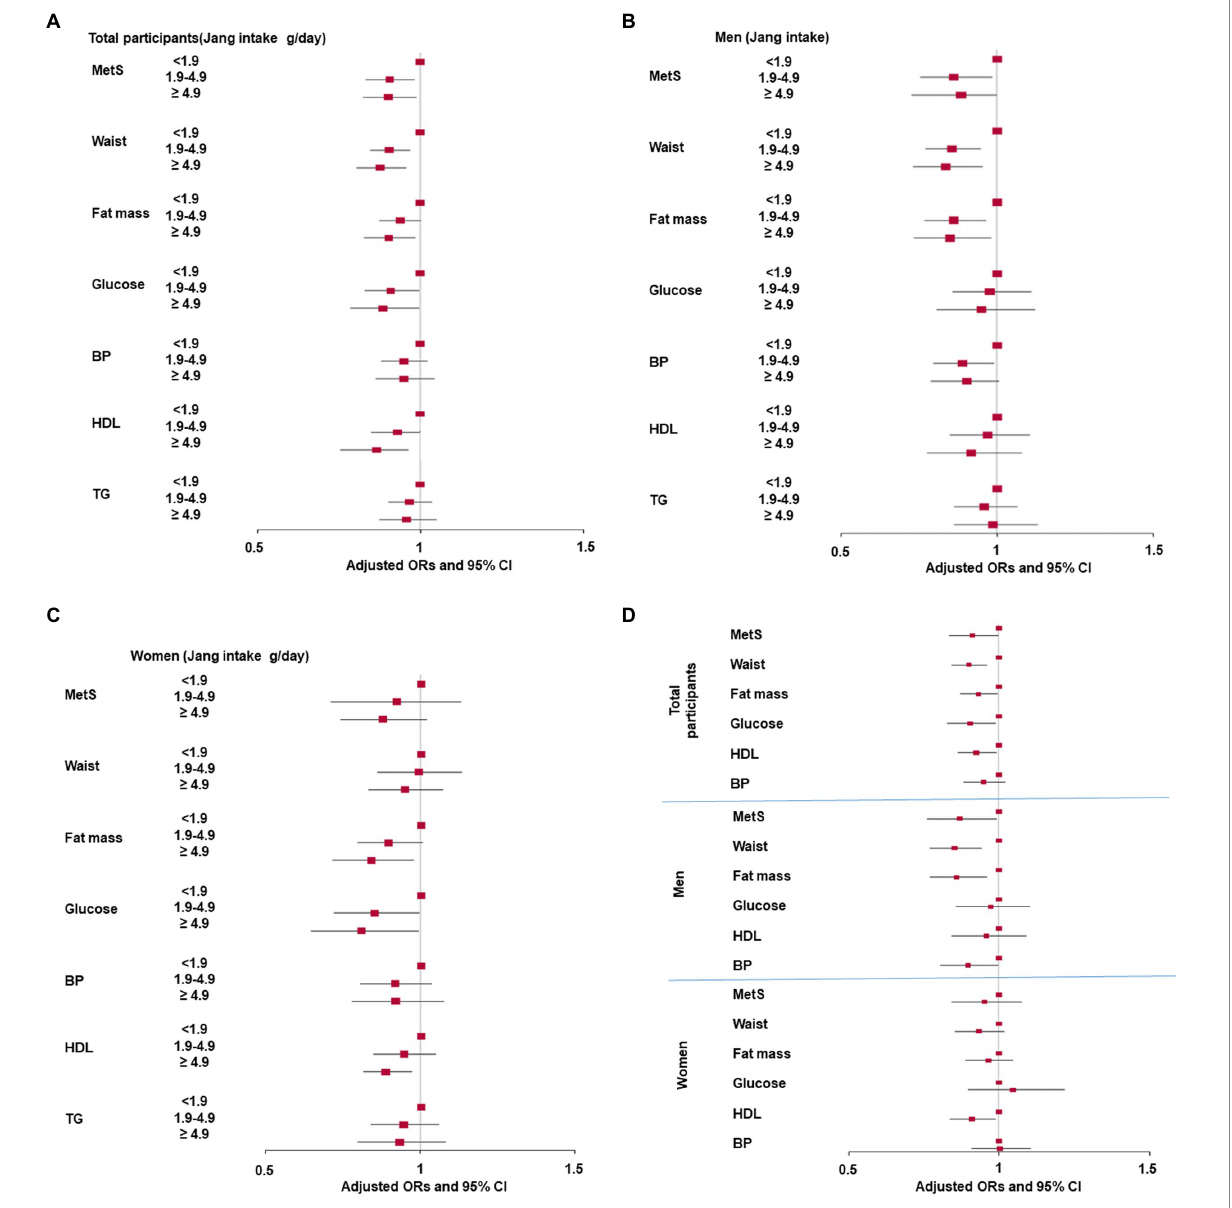
FIGURE 2 Association of Jang intake with metabolic syndrome (MetS) and its components according to gender (A) Adjusted odds ratio and 95% confidence intervals of MetS with Jang intake by tertiles in total participants (B) Adjusted odds ratio and 95% confidence intervals of MetS and its components with tertiles of Jang intake in men. Low intake <1.9 g Jang/day; Medium intake: 1.9 – <4.9 g/day; High intake: ≥ 4.9 g/day. (C) Adjusted odds ratio and 95% confidence intervals of MetS and its components with tertiles of Jang intake in women. Low intake <1.9g Jang/day; Medium intake: 1.9 – <4.9 g/day; High intake: ≥ 4.9 g/day, and (D) Adjusted odds ratio and 95% confidence intervals of MetS and its components with low-and high-Jang intake. (Cutoff: 1.9 g Jang intake/day) The cutoff points for logistic regression were as follows: MetS criteria; < 90 cm for men and 85 cm for women waist circumferences; <25% for men and 30% for women for fat mass; <110 mL/dL fasting serum glucose plus diabetic drug intake; <40 mg/dL for men and 50 mg/dL for women serum HDL cholesterol; <140 mmHg systolic blood pressure (SBP) or diastolic blood pressure (DBP) < 90 mmHg plus hypertension